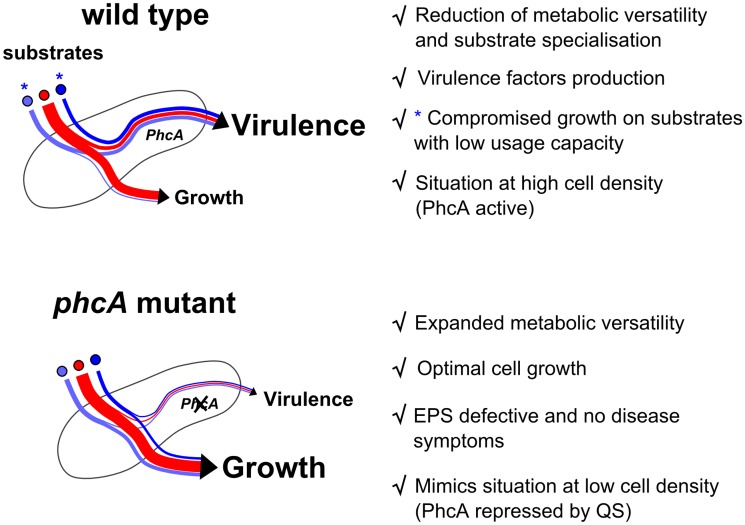
A summary of the PhcA-dependent growth/virulence trade-off in R. solanacearum.